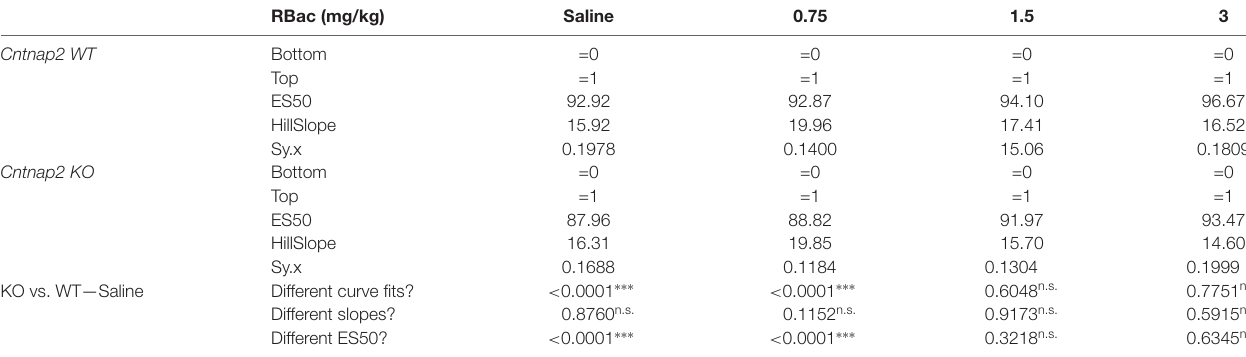
TABLE 3 | Comparison of sigmoidal regression fit of ASR I-O function with magnitude scaled between 0 and 1 in Cntnap2 WT and KO rats. RBac (mg/kg)